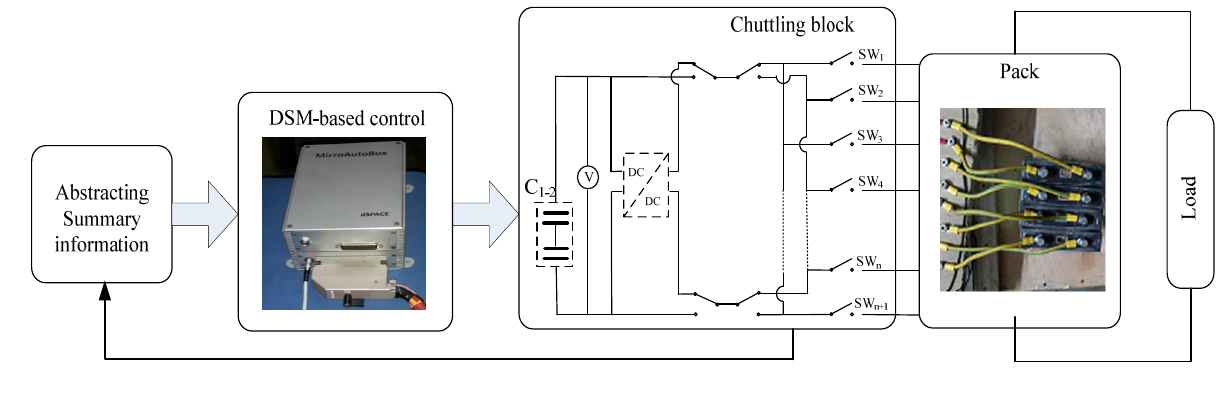
Figure 11. The global view of control circuit.